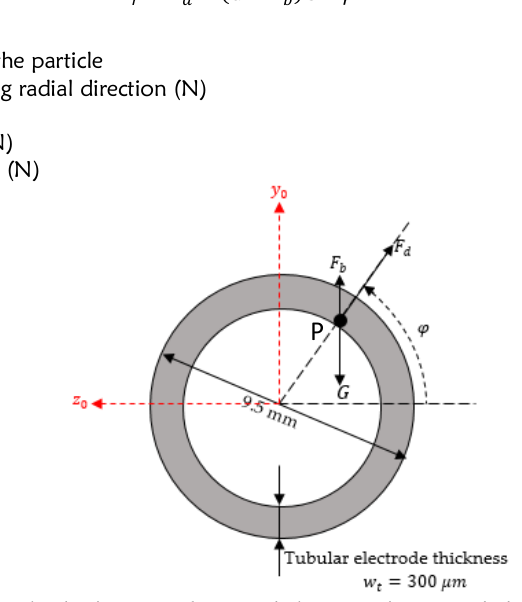
Figure 1 Free-body diagram of a particle between horizontal